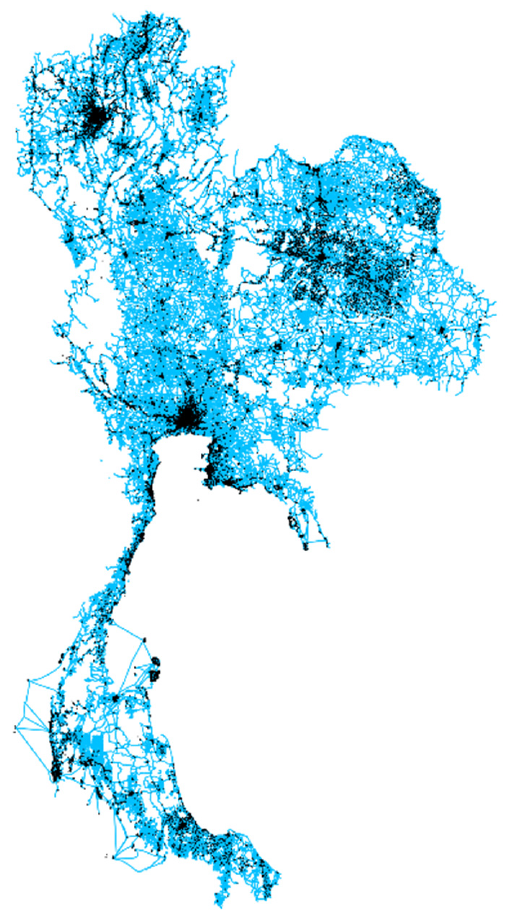
Figure 7. Spatial distribution of transportation network and POI in 2017. Source: OpenStreetMap.